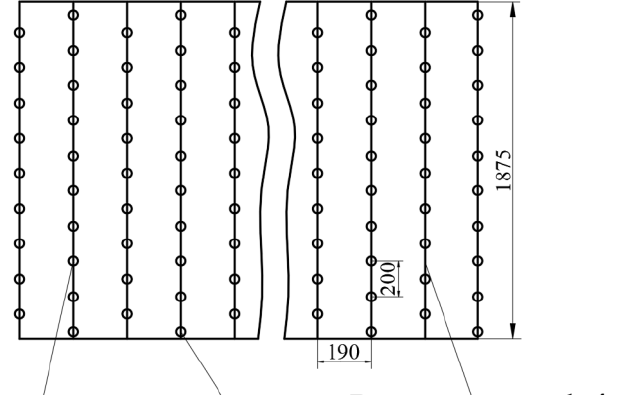
Figure 6. The spread layout of the film picking teeth.